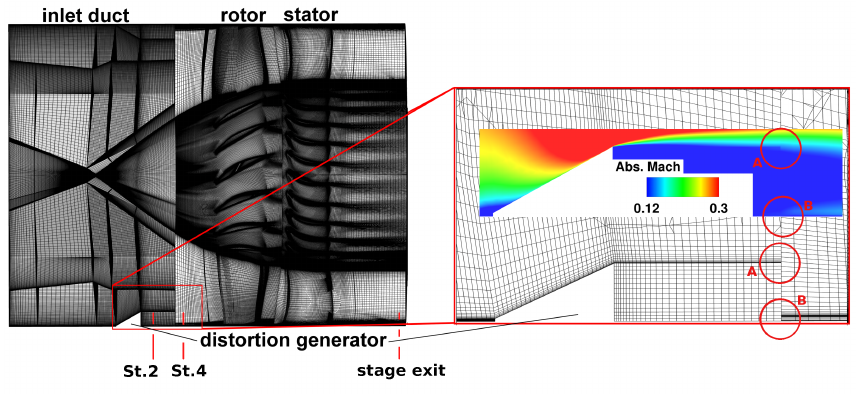
Figure 2. The structured mesh used for simulations with the TRACE flow